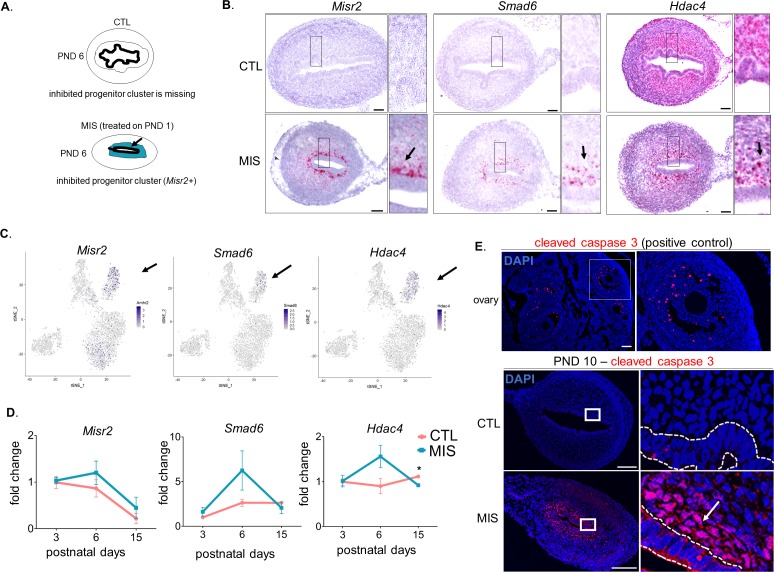
The inhibited progenitor cluster is only present in the MIS-treated uterus and corresponds to a subluminal mesenchymal cell.Rat or mouse pups were injected with empty vector control (CTL) or with AAV9-MIS (MIS) on PND 1 and analyzed at different developmental time points (A–E). (A) Representative schema of the CTL and MIS-treated uteri at PND6. Note that the MIS-inhibited subluminal mesenchymal cell cluster (blue) is missing in the control uterus. (B) Control and MIS-treated mice uteri probed by RNAish using specific inhibited progenitor cluster markers at PND 6 (Misr2, Smad6, and Hdac4). Note that the Misr2+ cells reside in the subluminal space and express the anticipated markers identified by scRNAseq (shown by arrows in small inserts). Scale bars = 50 µm. (C) Expression pattern of Misr2, Smad6, and Hdac4 (markers for the MIS-inhibited cluster) in CTL and MIS treated cells on the t-SNE plots (FeaturePlot). Black arrows indicate the inhibited progenitor cells' cluster. (D) QPCR analysis of Misr2, Smad6, and Hdac4 in CTL (orange) and MIS-treated (blue) rat uteri at different developmental time points. (n > 2 for all time points, unpaired Student’s t test, mean ± SEM), *(p<0.05), **(p<0.01), (Figure 3—source data 3). (E) Cleaved-caspase-3 immunofluorescence (red) on ovarian (positive control), and MIS-treated rat uteri at PND 10. Note that only the MIS-treated subluminal cells (white arrows) are positive for cleaved caspase-3 on uterine sections. Scale bars = 50 µm.